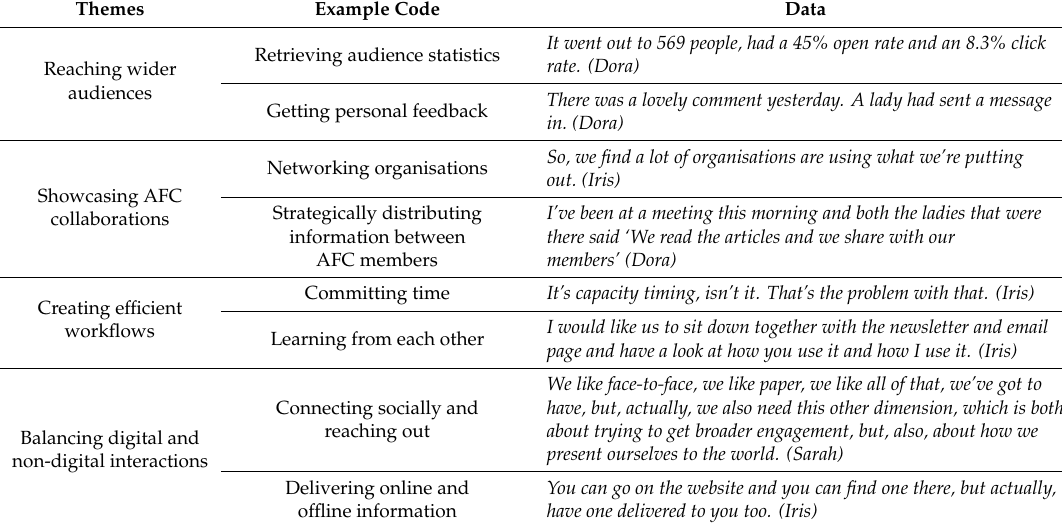
Themes, example codes and data from the thematic analysis (TA) exploring the digital